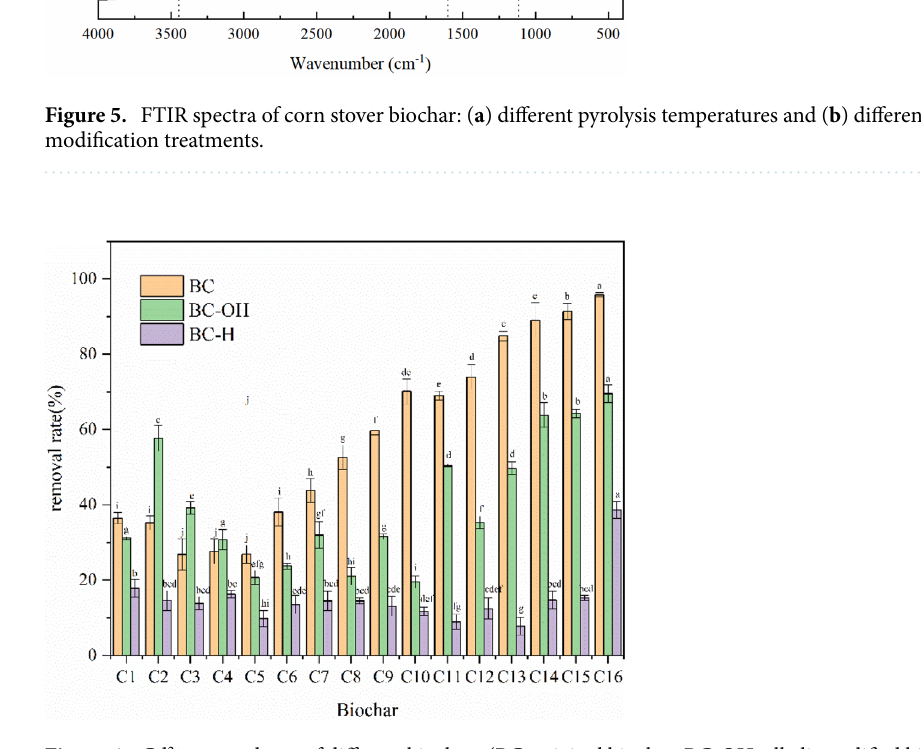
Figure 6. Cd 2+ removal rate of different biochars (BC: original biochar, BC-OH: alkali-modified biochar, and BC-H: acid-modified